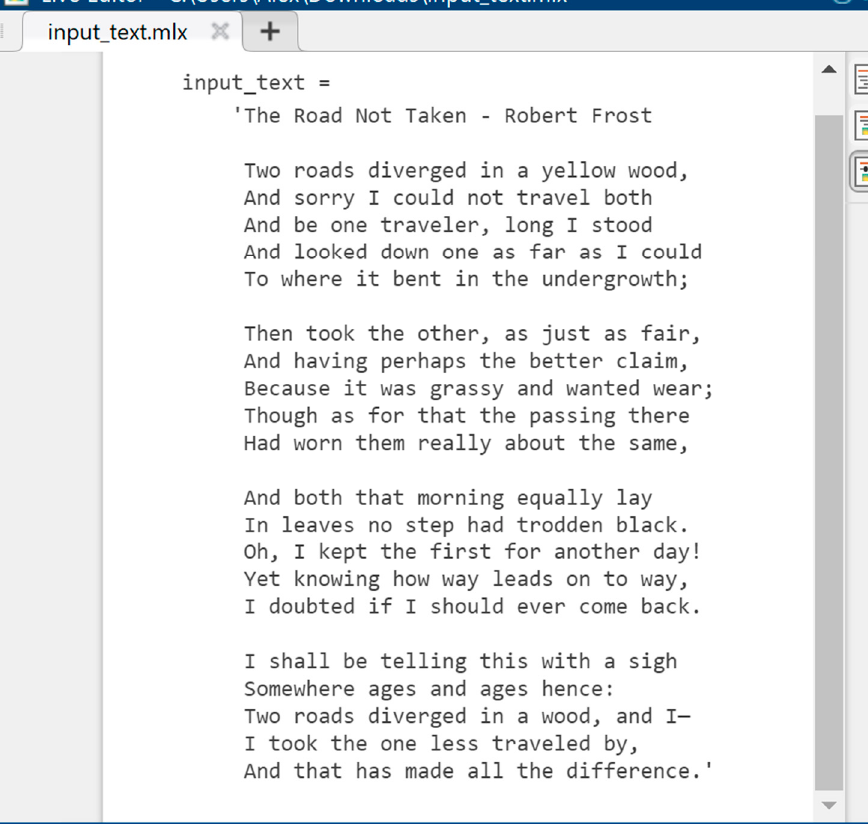
Figure 7. Original text information in the form of ASCII codes.